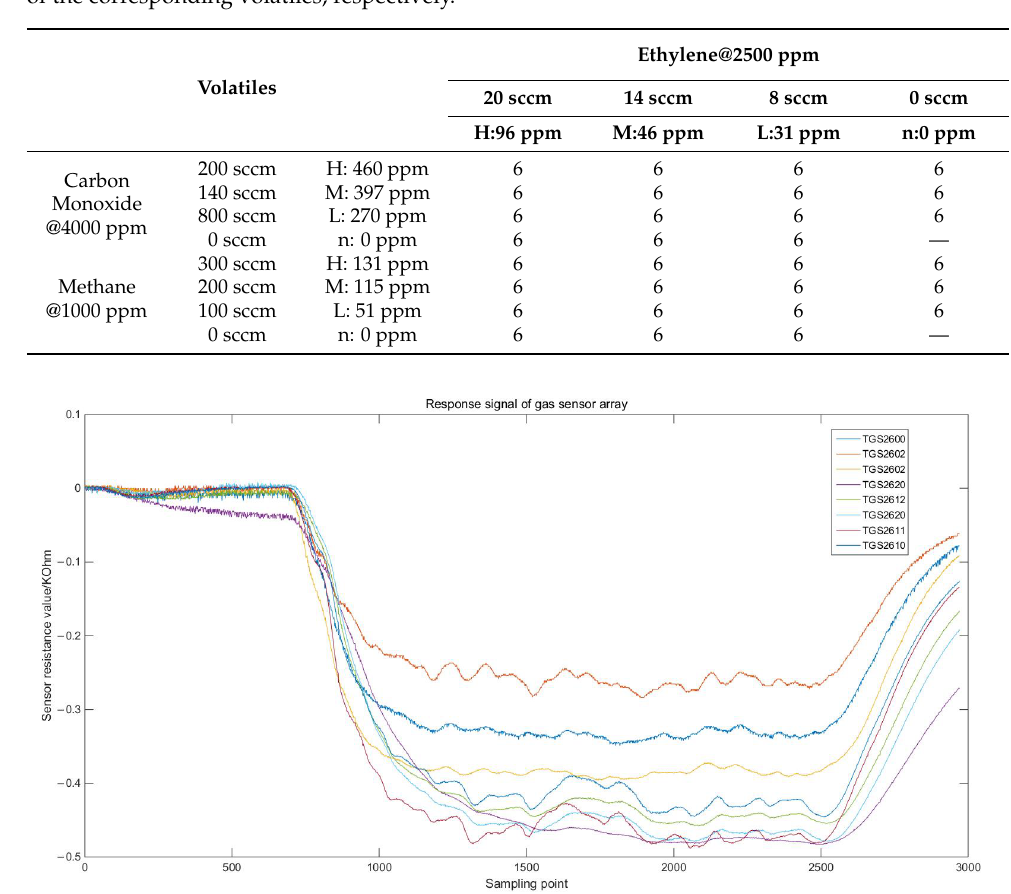
Table 3. Sample distribution in the dataset along with rate of chemical release (in sccm) and corre- sponding induced gas concentration level (in ppm) in the vicinity of the sensors. In total, 180 measure- ments were performed. The labels H, M, L, and n indicate high, medium, low, and zero concentrations of the corresponding volatiles, respectively.